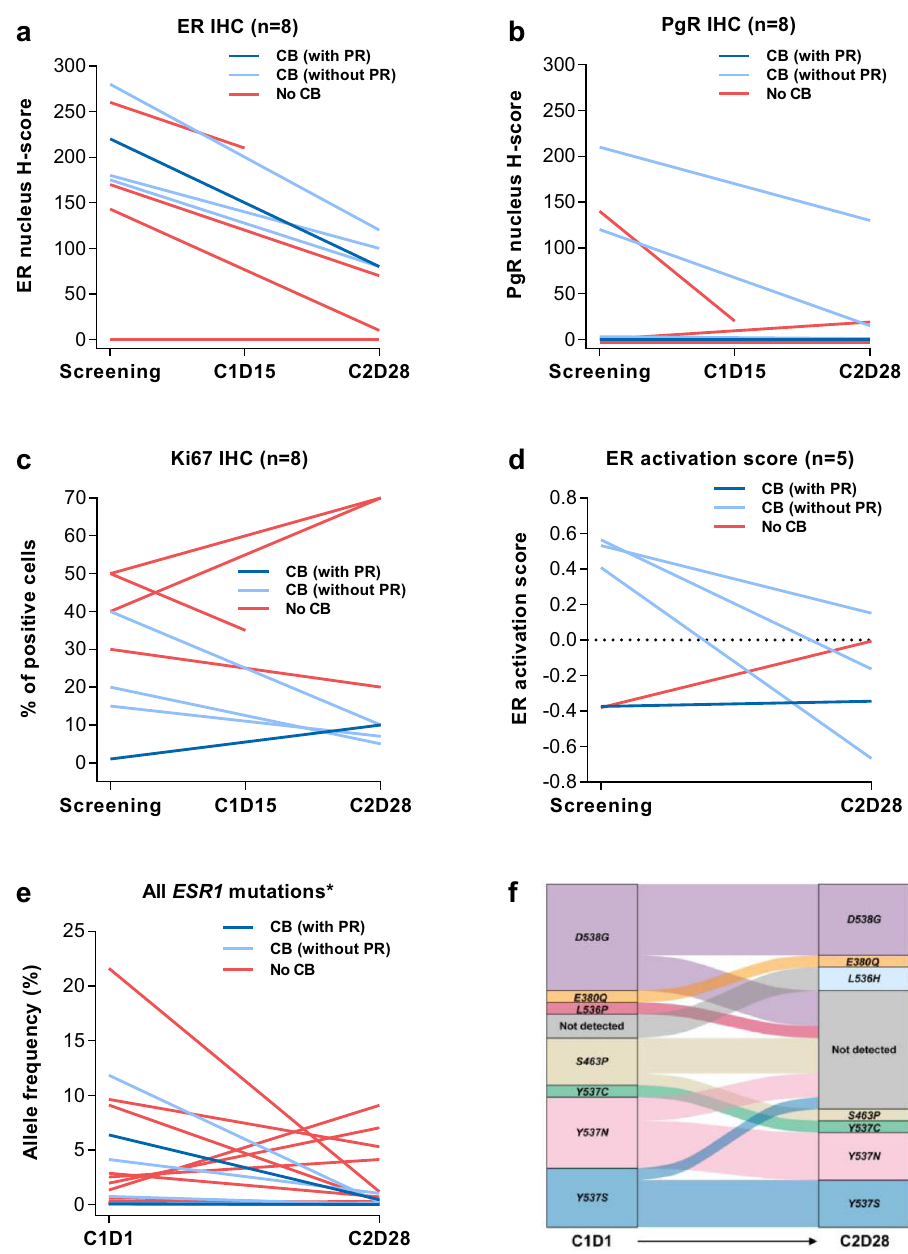
Fig. 4 Post hoc exploratory biomarker analyses of on-target ER degradation/pathway inhibition during amcenestrant therapy. Changes from screening to cycle 2, day 28 in a ER nucleus H-score by IHC; b PgR nucleus H-score by IHC; c percent of positive cells showing Ki67 protein expression by IHC; and d ER activation scores by GSVA; and changes from cycle 1, day 1 to cycle 2, day 28 in e allele frequency of ESR1 mutations in cfDNA by ddPCR; and f numbers of ESR1 mutations in cfDNA by ddPCR. *Each line refers to an ESR1 mutation, but several lines may refer to a single patient. C1D1, cycle 1, day 1; C1D15, cycle 1, day 15; C2D28, cycle 2, day 28; CB clinical bene fi t (complete response + partial response + stable disease ≥ 24 weeks), cfDNA circulating free DNA, ddPC, droplet digital polymerase chain reaction, ER estrogen receptor, ESR1 estrogen receptor 1, GSVA gene set variation analysis, IHC immunohistochemistry, PgR progesterone receptor, PR partial